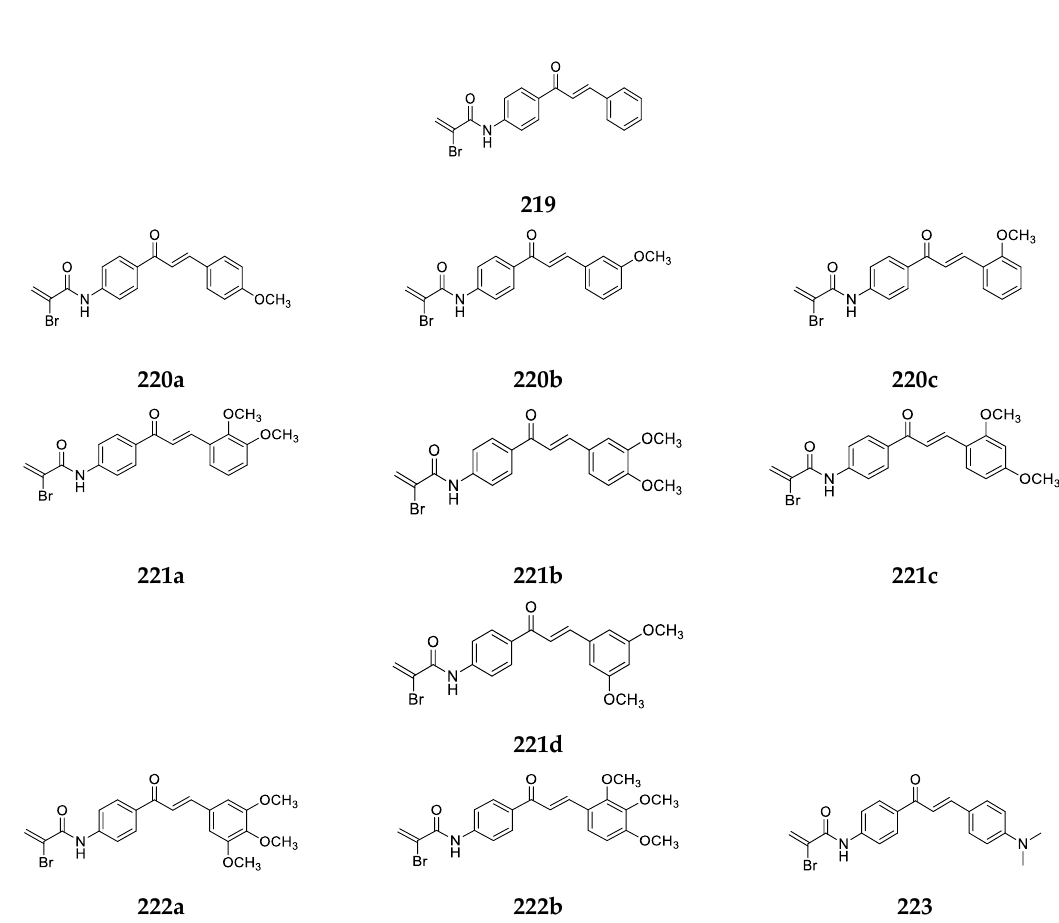
Figure 69. Chemical structure of α-bromoacryloylamido chalcone derivatives with substitution on ring B.